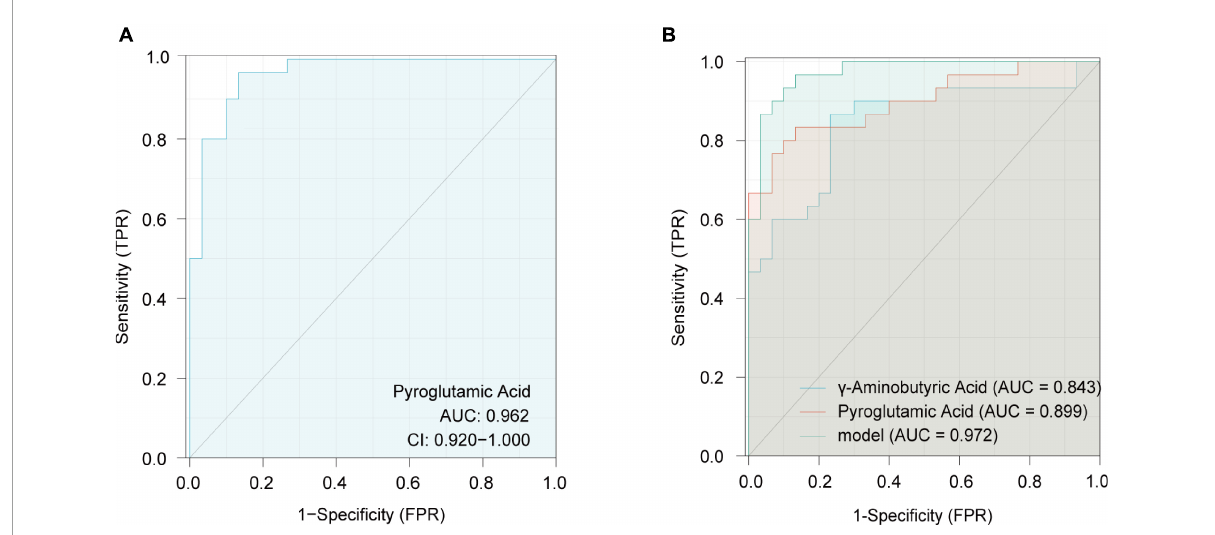
FIGURE6 Receiver operating characteristics (ROC) curves in the GDM group for pyroglutamic acid (A) and in the HP group with joint indicators, including pyroglutamic acid and γ -aminobutyric acid (B)